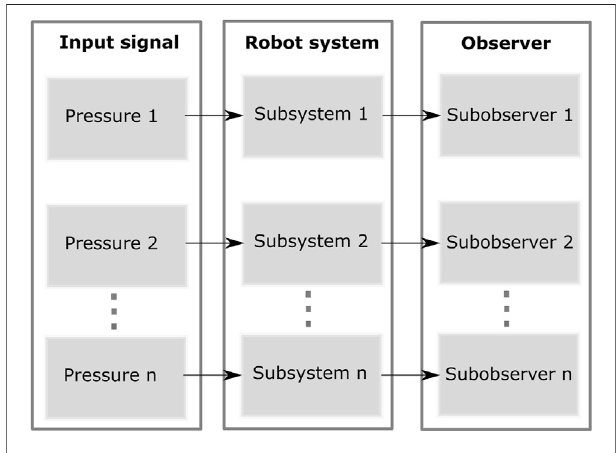
FIGURE 8 | Switching rule.